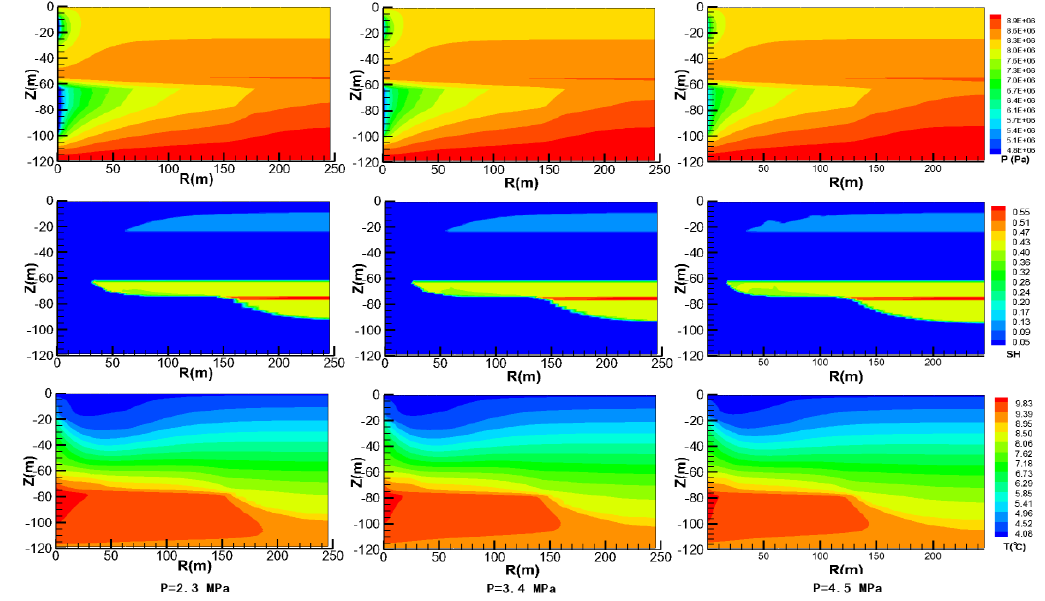
Figure 14. Sensitivity to the production pressure ( P W ): evolution of P , S H , and T distribution at t = 30 years.